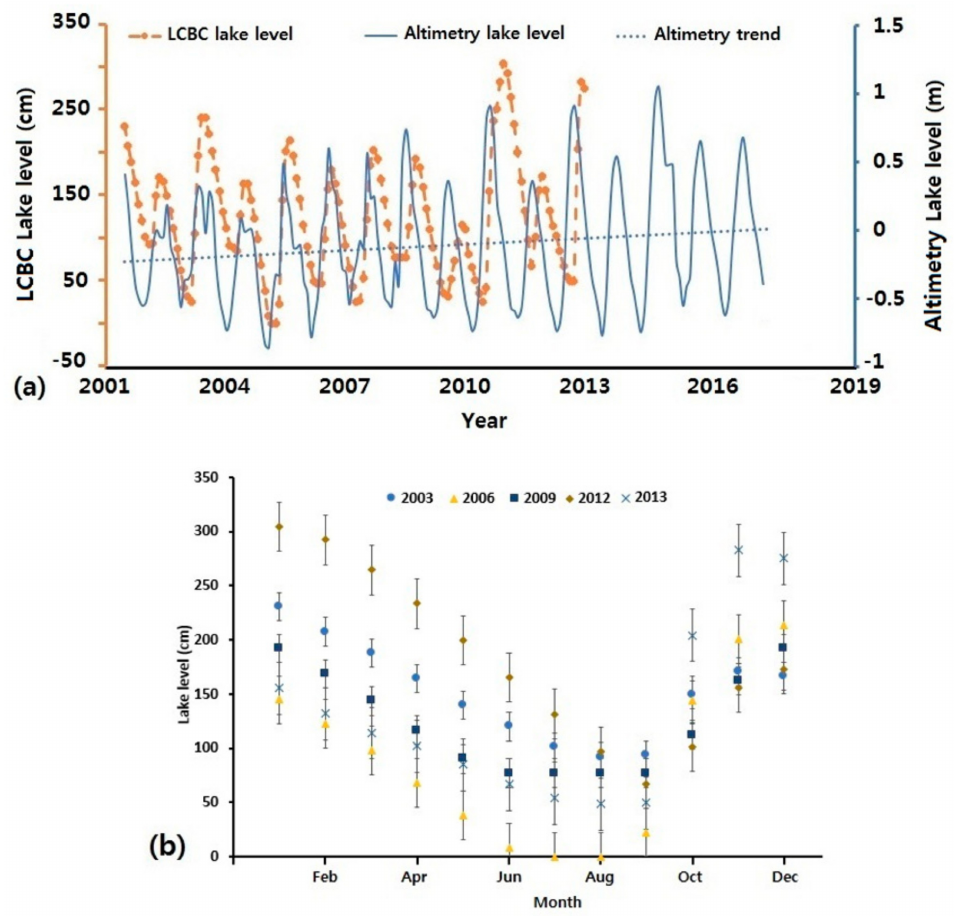
Figure 2. ( a ) Lake levels for 1990–2012. ( b ) Monthly LCBC lake levels at Bol village. The error bars represent the standard deviation for each